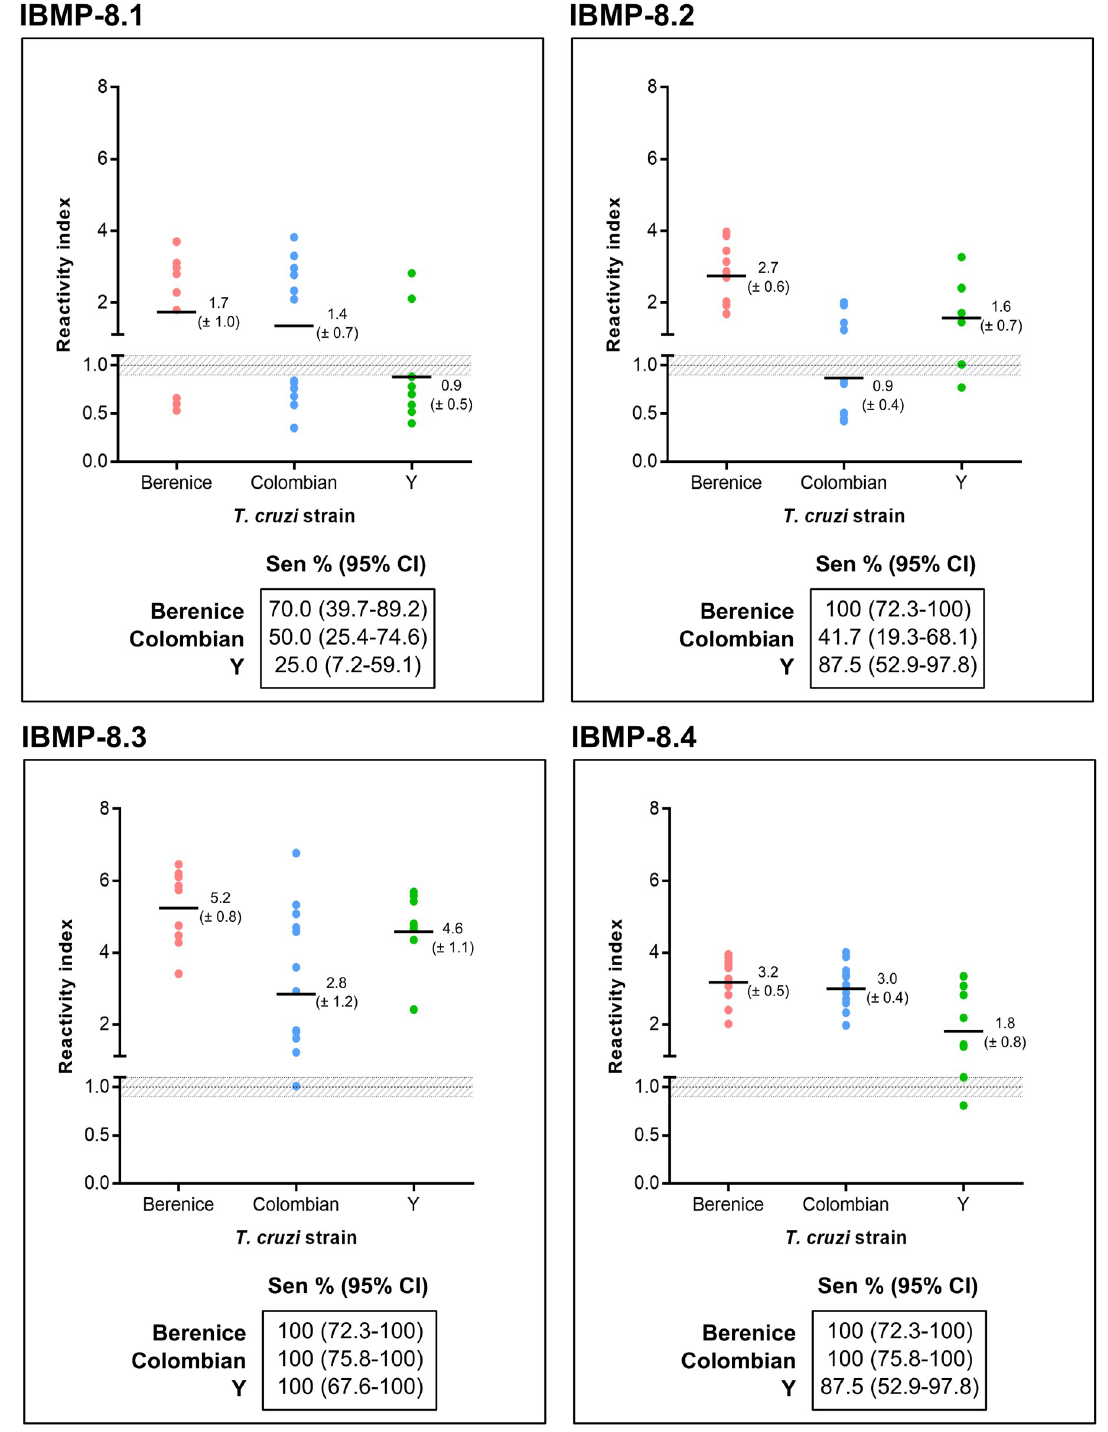
Fig 4. Reactivity index for antigen performance for the different Trypanosoma cruzi strains tested. The cut-off is set at the reactivity index value = 1.0 and the shadowed area represents the grey zone (RI = 1.0 ± 0.10). Horizontal lines and numbers for each results group represent the geometric means ( ± 95% CI). CI (confidence interval); Sen